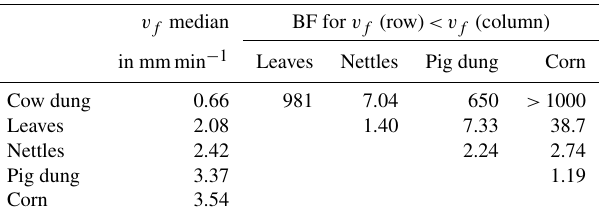
Table 4. Comparison of v f of DOC depending on leachate source by the BF of one v f being lower than the other one. Additionally, the table presents median values of the v f distributions in millime- tres per